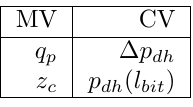
Figure 6: Casing shoe